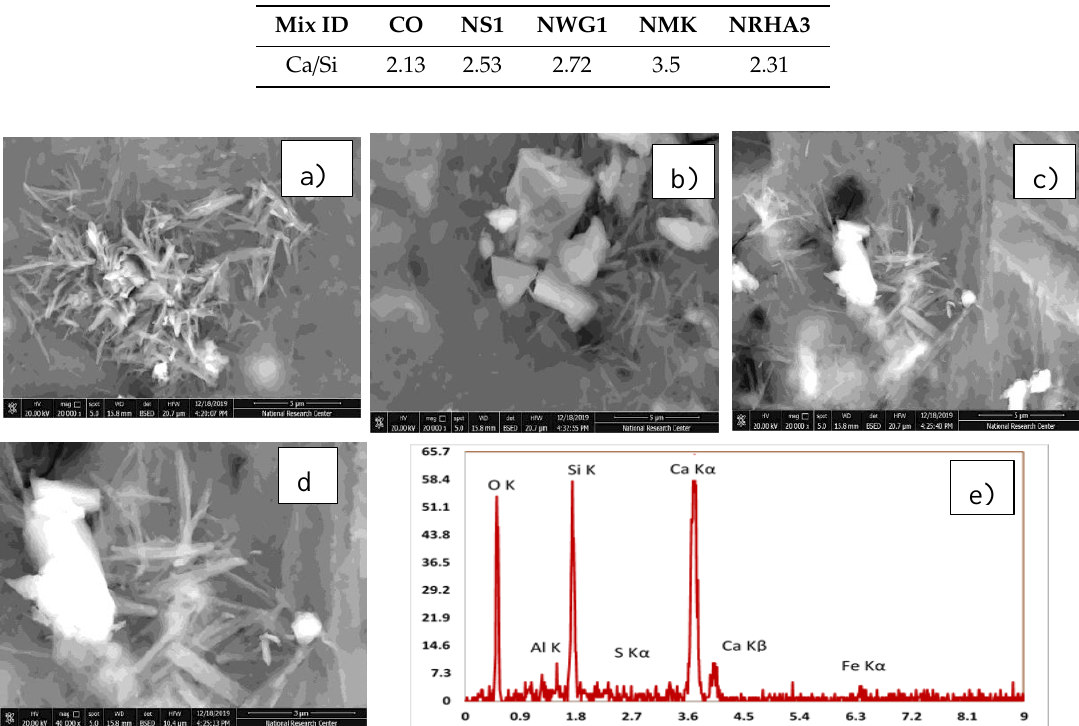
Figure 13. SEM and ( a – d ) SEM images at different magnification factor and ( e ) EDX for the UPC mix incorporating 1% nanosilica.